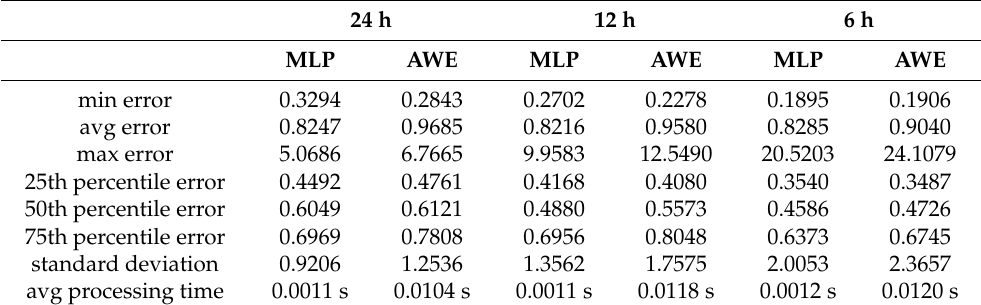
Table 5. Efficiency of machine learning-based traffic prediction for WASK dataset for different time